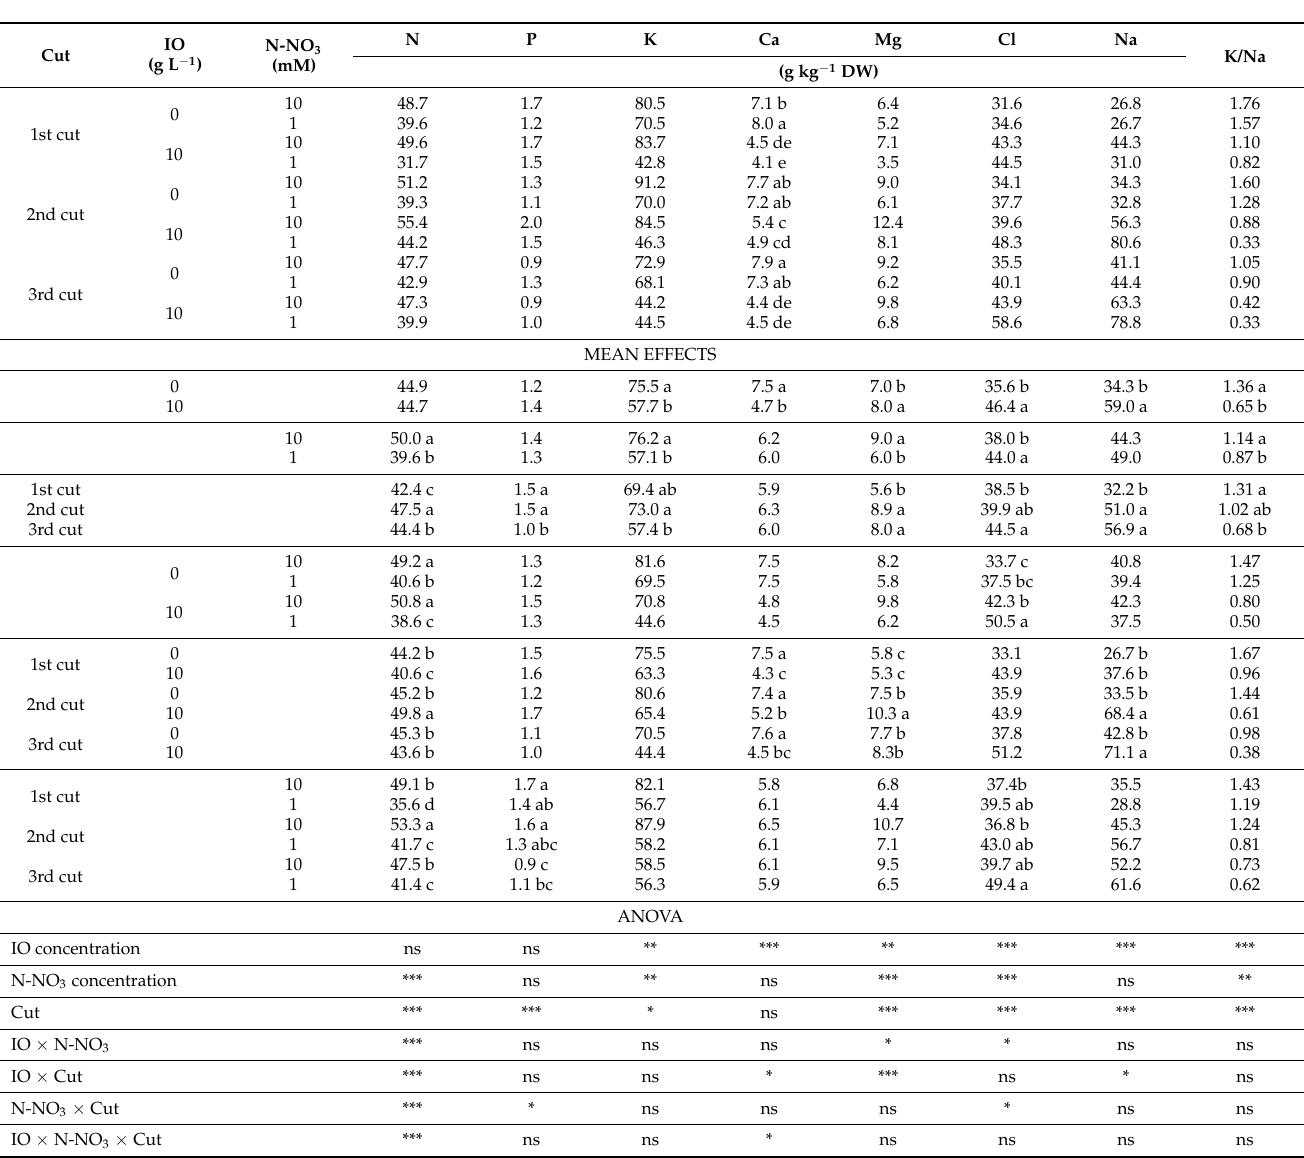
Table 6. Leaf concentration of nitrogen (N); phosphorus (P); potassium (K); sodium (Na); calcium (Ca); magnesium (Mg); and chloride (Cl), and K/Na molar ratio in Swiss chard plants grown hydroponically with different concentrations of the sea salt Instant Ocean (IO; 0 and 10 g L − 1 ) and nitrate (NO 3 ; 1 and 10 mM) in the nutrient solution. The leaves were harvested trice during the experiment (see Table 1 for more detailed information in the